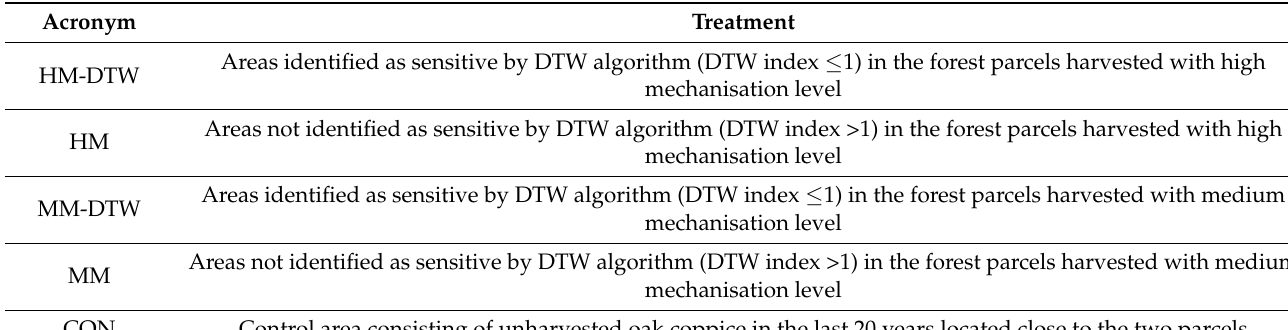
Table 2. Acronyms for the experimental